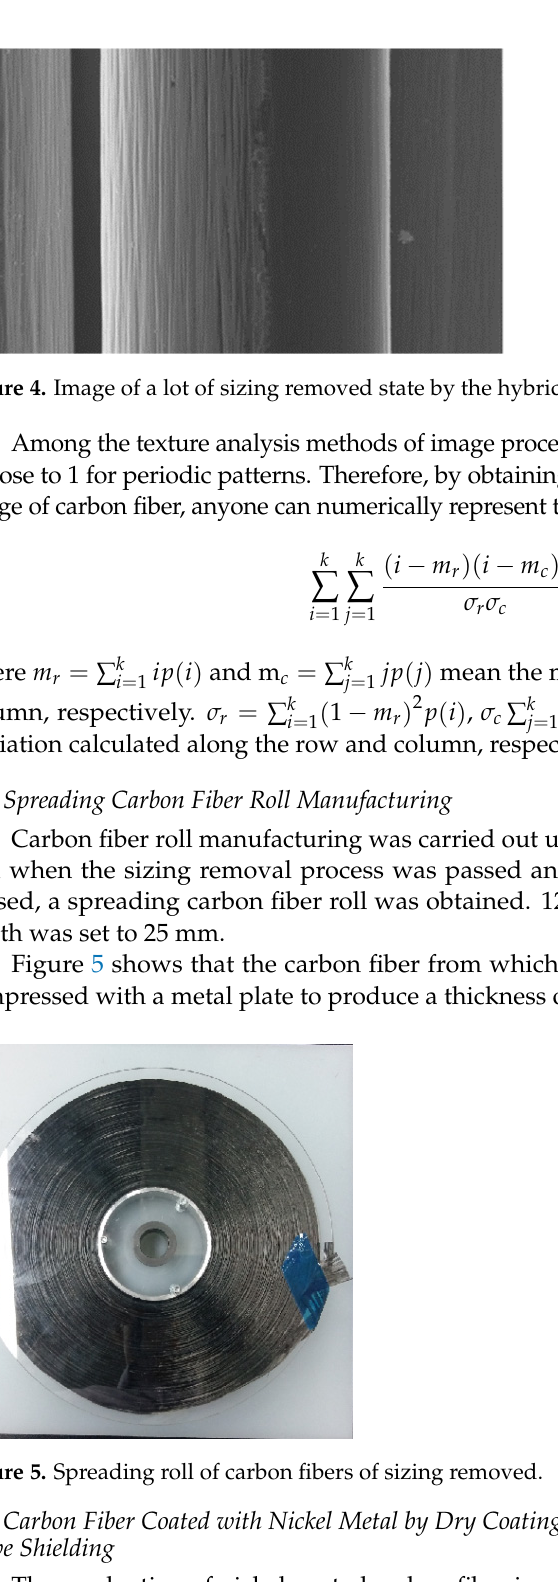
Figure 5. Spreading roll of carbon fibers of sizing removed.